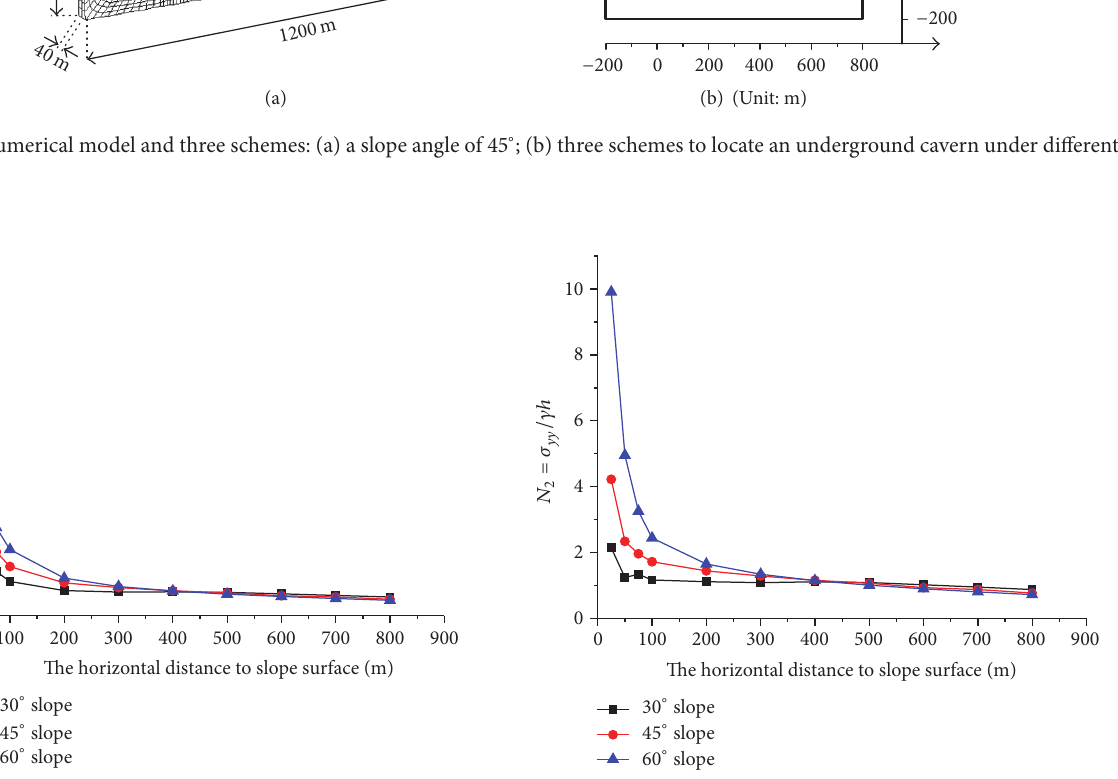
Figure 2: Variation curves of 𝑁 1 at the elevation of 0 m in different slope angles only considering the gravity stress.